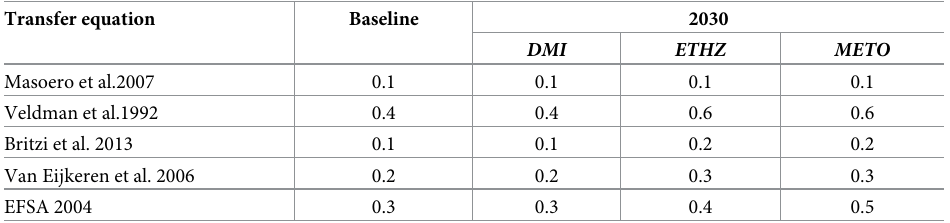
Table 5. Maximum weekly percentage of simulations above the EC limit of 0.05 μ g/kg AfM1 in milk from the whole farm, assuming compound feed contains maize imported from Ukraine. This percentage is calculated as number of simulations above the threshold/10000 x